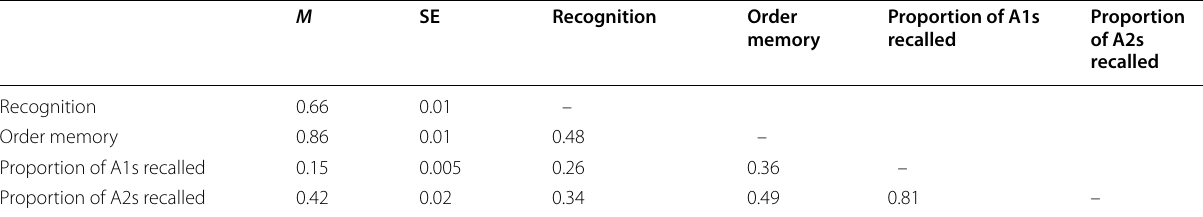
Table 3 Memory performance and Pearson correlations of each of the different memory measures